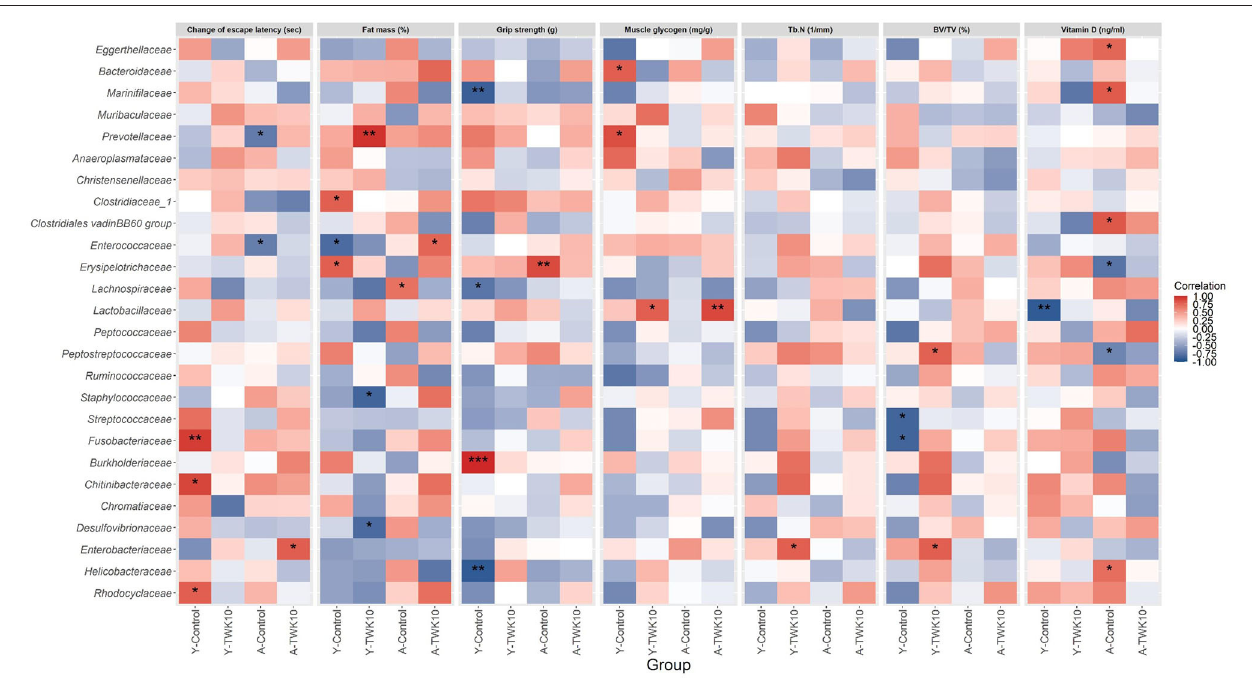
FIGURE 6 | Heatmap of Spearman’s correlation analysis between the gut microbiota and the altered age-related host phenotypic features. Spearman’s correlation analysis was performed to investigate the correlations between the relative abundances of 26 major families and the values of seven altered aged-related host phenotypic features selected from the differential analysis between Y-Control and Y-TWK10 or A-Control and A-TWK10 groups. Red squares indicate positive correlations and blue squares indicate negative correlations. * P < 0.05, ** P < 0.01, *** P <